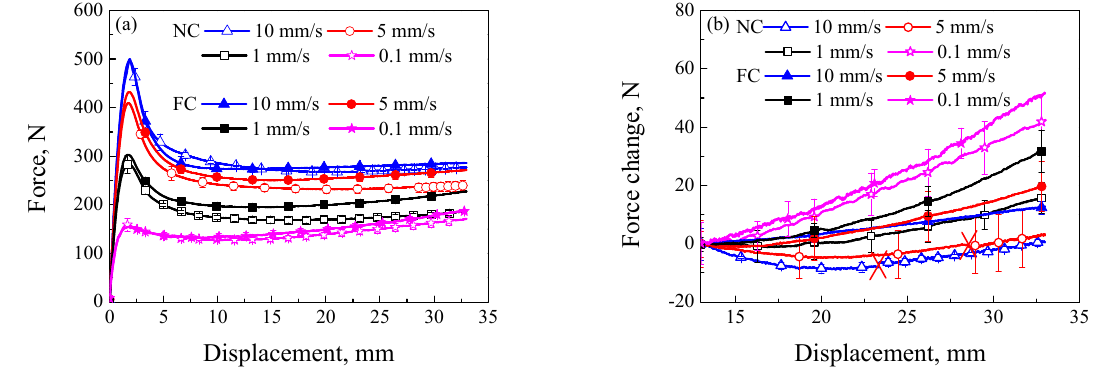
Figure 4. ( a ) Curves of force and displacement at different loading rates; ( b ) curves of force change and displacement at the plastic flow stage at different loading rates (symbol ‘×’ denotes the fracture of specimens at the loading displacement).